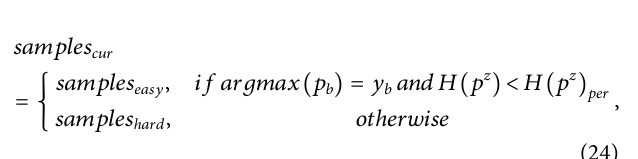
Frontiers in Genetics |